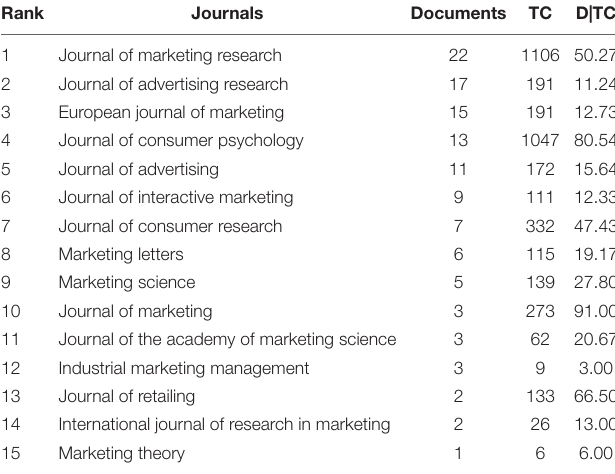
TABLE 1 | Summary of journals